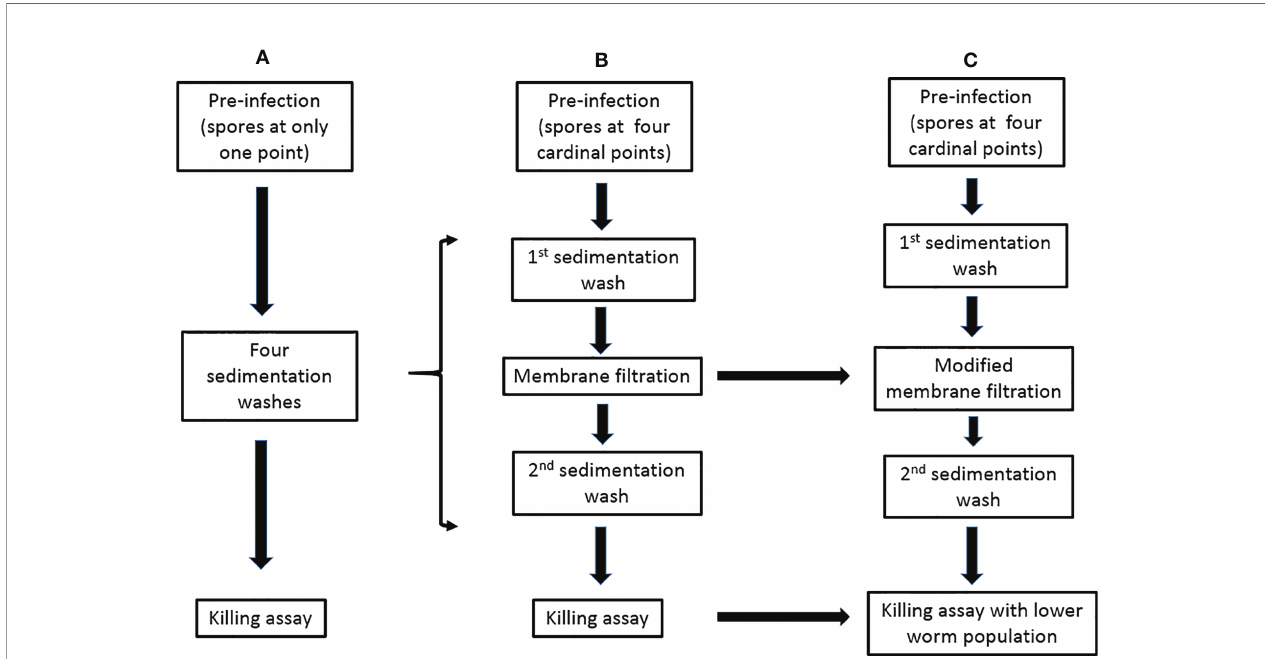
FIGURE 1 | Modi fi cations of the preinfection to killing assays for the C. elegans -mold infection model. (A) The previously described procedure (Okoli and Bignell, 2015). (B) The procedure in our publication (Ahamefule et al., 2020a). (C) Our proposed modi fi